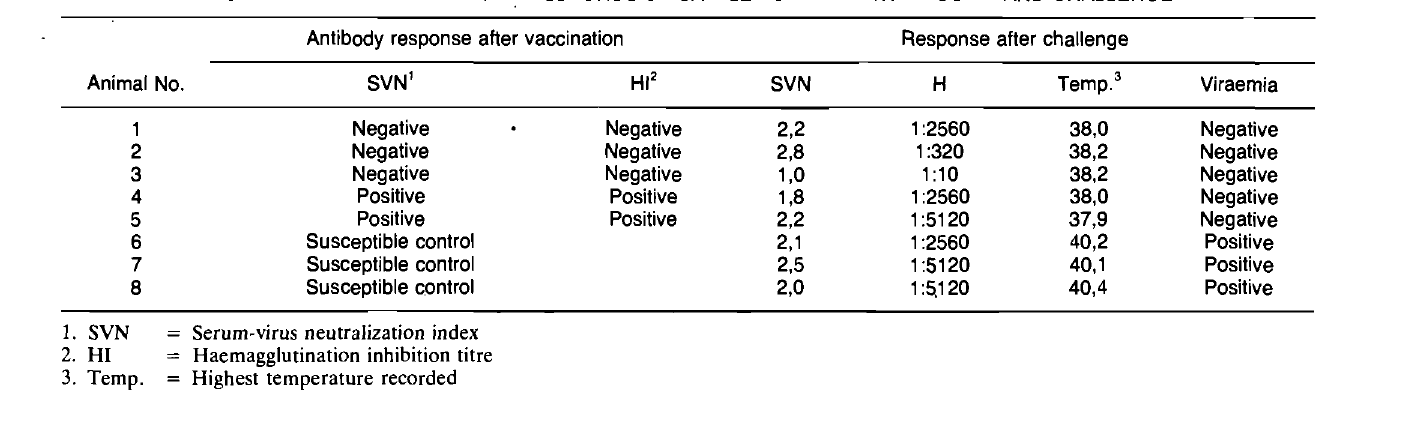
Table 2: ANTIBODY AND IMMUNE RESPONSE OF CATILE TO A LIVE RVF VACCINE AND CHALLENGE Antibody response after vaccination Animal